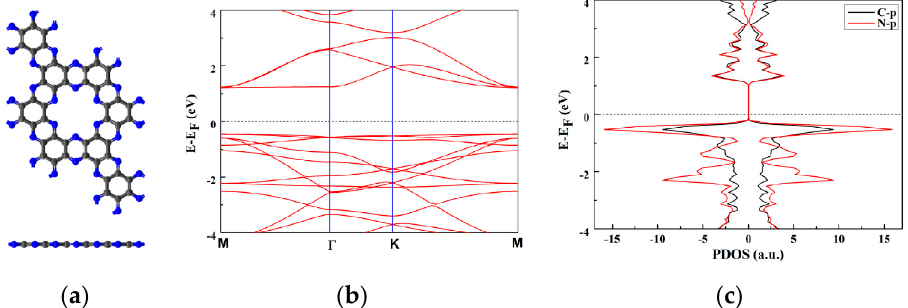
Figure 5. Top and side view of the structure of C 2 N in a 2 × 2 supercell ( a ) and band structure ( b ) and projected density of state (PDOS) ( c ) of the C 2 N, the Fermi level is set to zero .